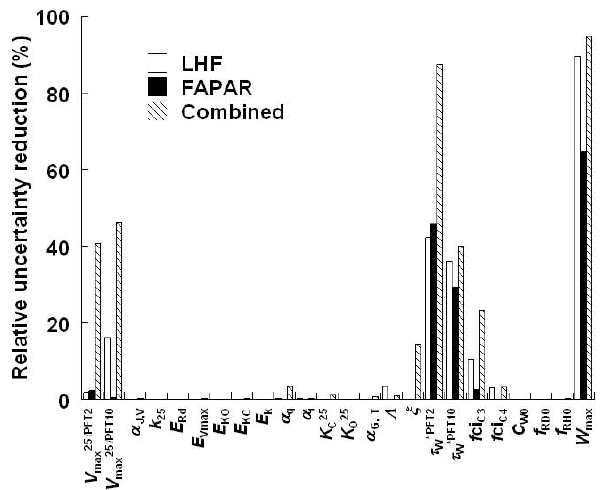
Fig. 2. Relative reduction (%) in parameter uncertainty after opti-